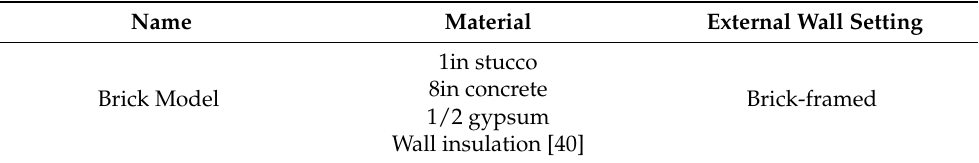
Table A2. Brick case study construction